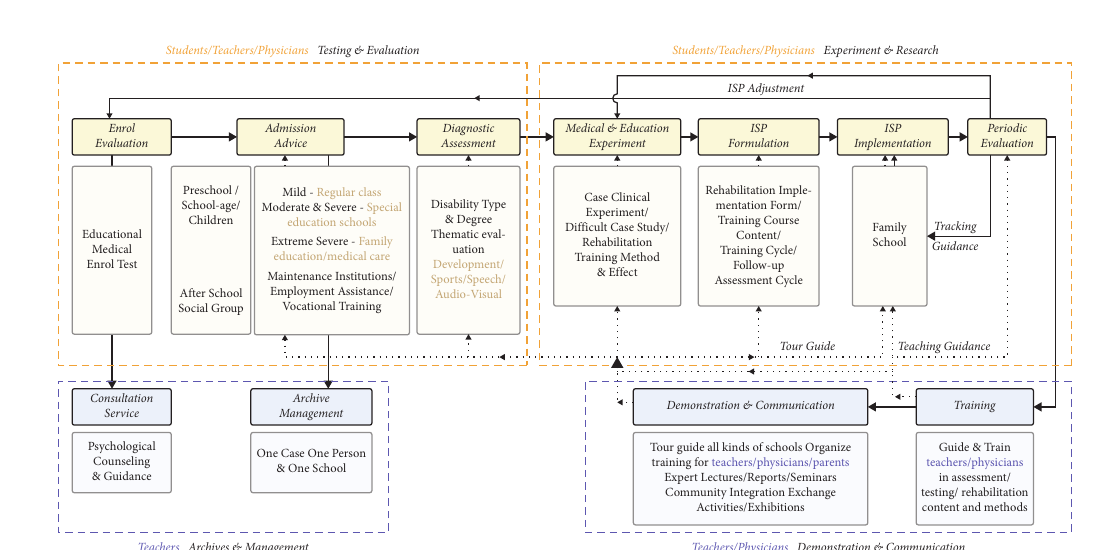
Figure 7: Function composition and behavior flow chart.